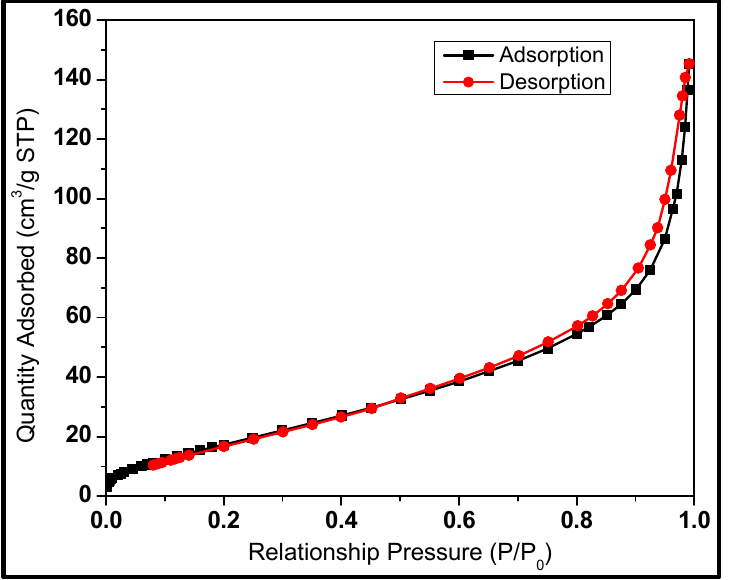
Figure 3. N 2 adsorption-desorption isotherm for the powder SCBA nano silicon prepared by thermo-chemical method.